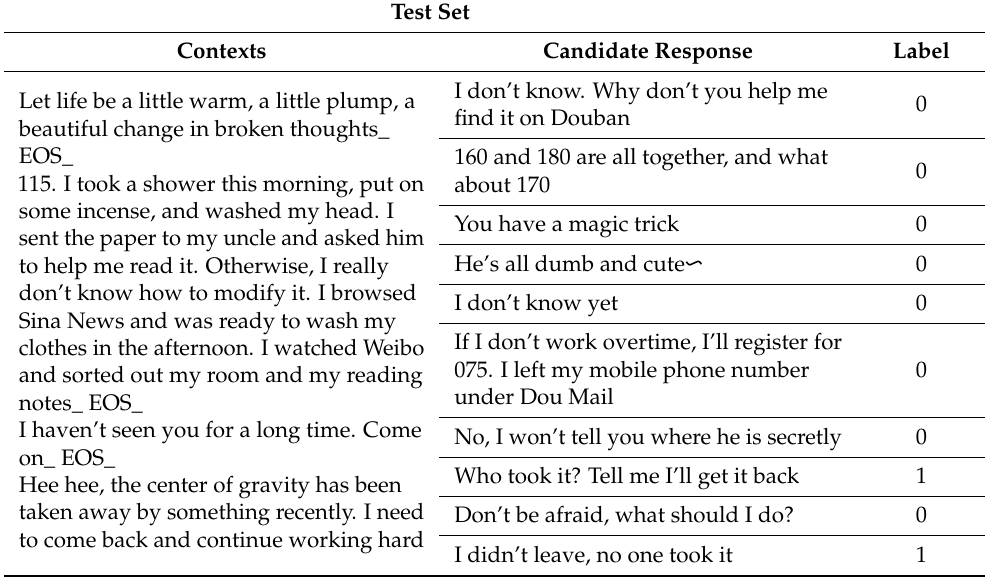
Table 4. Douban Data Set (Chinese Test Set).